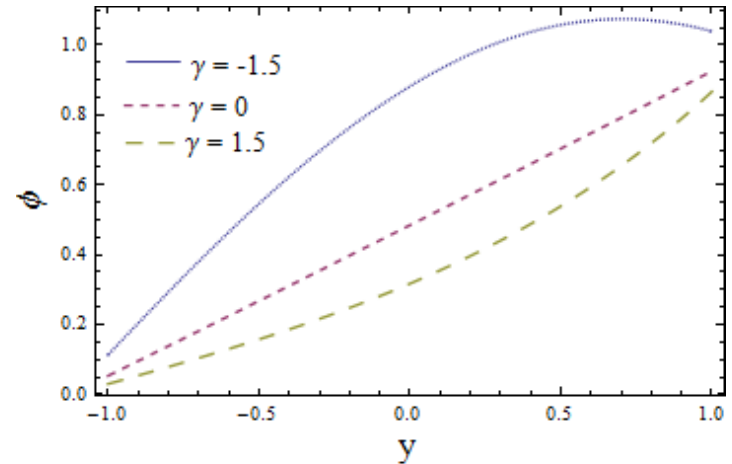
Figure 11. Mass concentration φ versus y for γ when (cid:101) = 0.2, τ ∗ = 0.1, x = 0.1, t = 0.1, γ h 1 = 6,